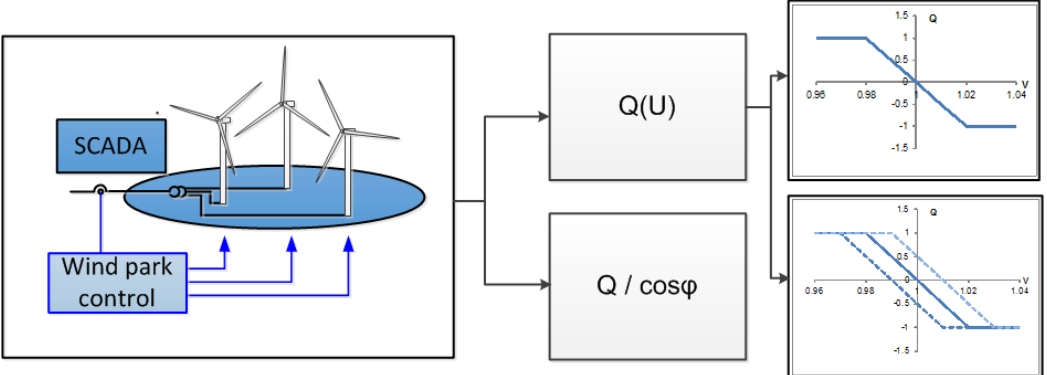
Figure 3. Different control modes for wind farms including possible parametrization of the Q(U) control.